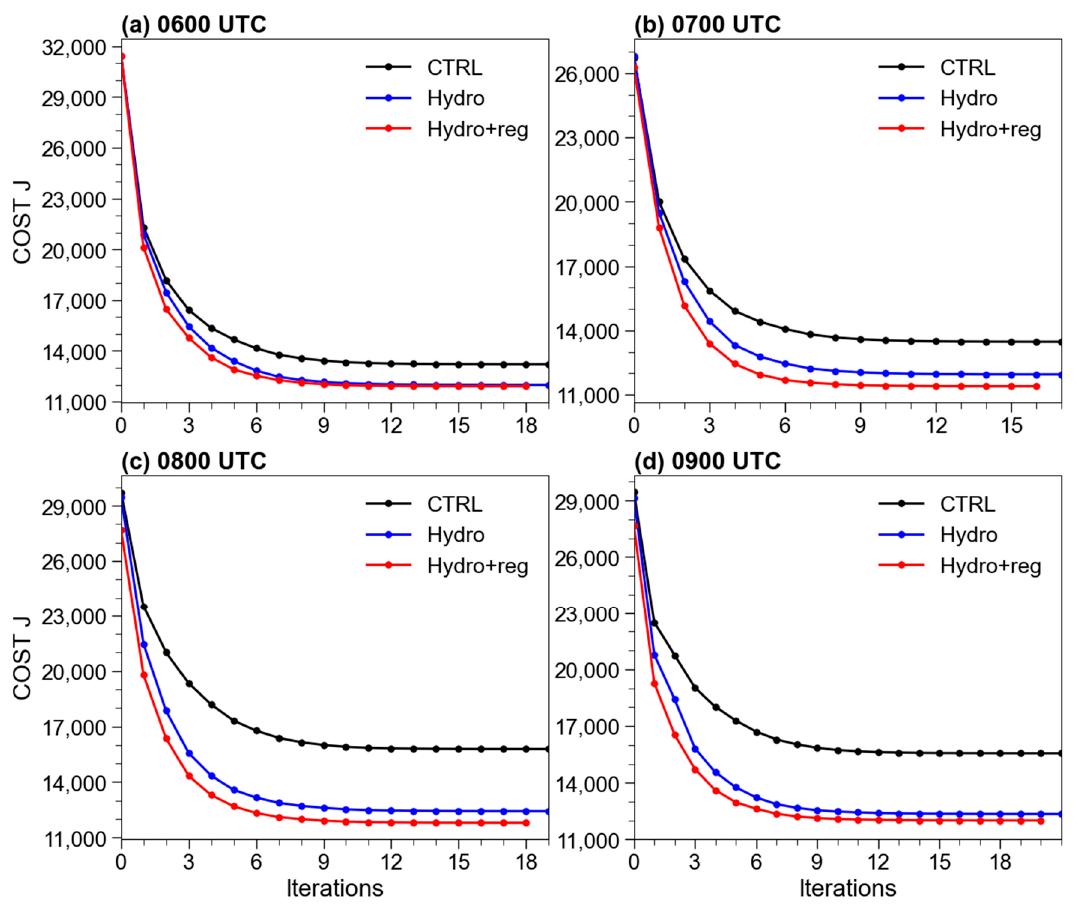
Figure 10. Variation of the cost function in radar data assimilation at ( a ) 0600 UTC (cycle 1), ( b ) 0700 UTC (cycle 2), ( c ) 0800 UTC (cycle 3), and ( d ) 0900 UTC (cycle 4).